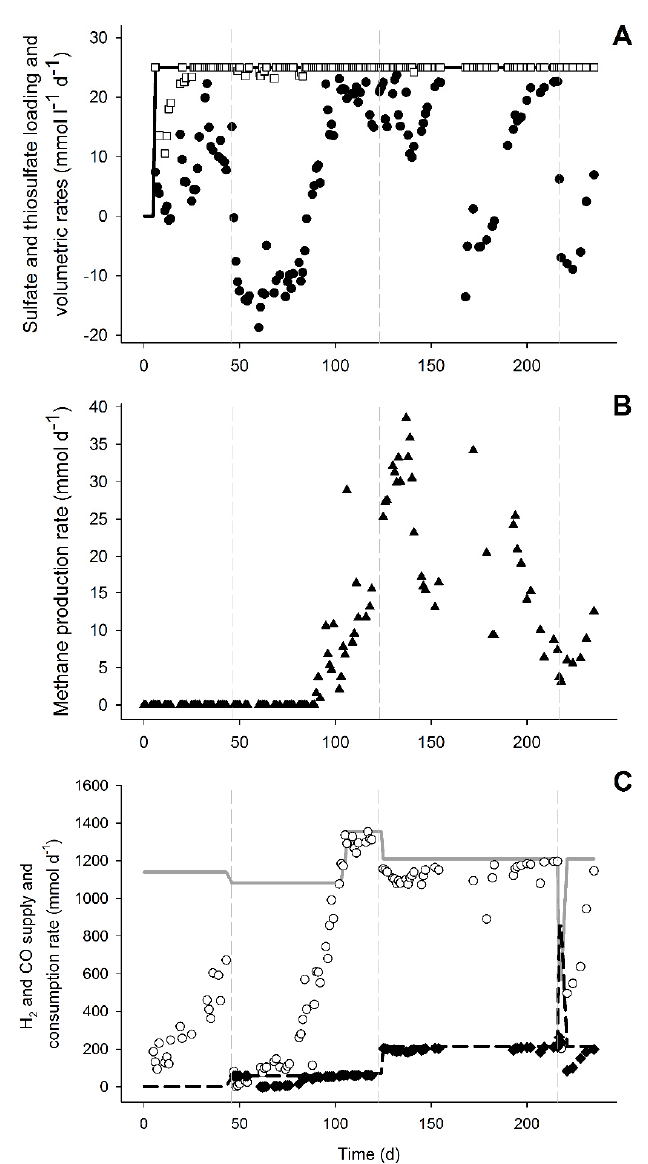
Figure 2. Metabolic rates and electron donor consumption during the bioreactor experiment. ( A ) Sulfate and thiosulfate loading rate (represented by the continuous line), sulfate ( ● ), thiosulfate ( □ ), and volumetric reduction rates (r vs ). ( B ) Total methane production rate (r vp ). ( C ) Supply of H 2 (continuous line) and CO (dashed line) along with consumption rate of H 2 ( ○ ) and CO ( ♦ ). Vertical dashed lines represent the start of CO addition: 5% CO (1st), 15% CO (2nd), and 60% CO spike (3rd).